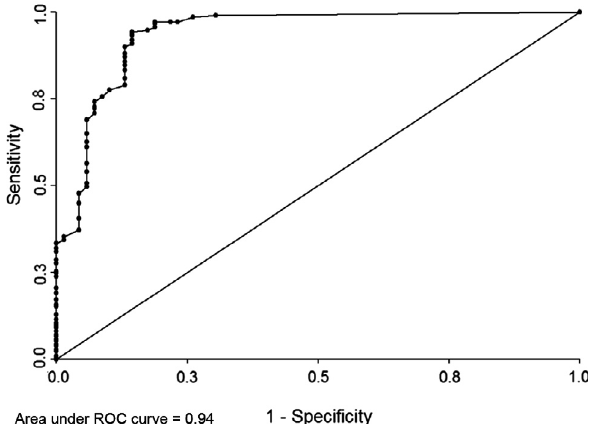
Figure 2. Receiver operating characteristic curve for 298 IgG negative (<6 UI/mL) or equivocal (6–9 UI/mL) and IgM negative